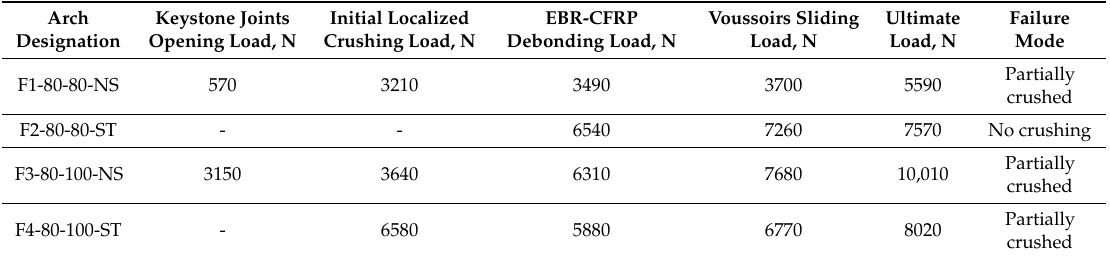
Table 5. Test results of self-form segmental concrete masonry arches.